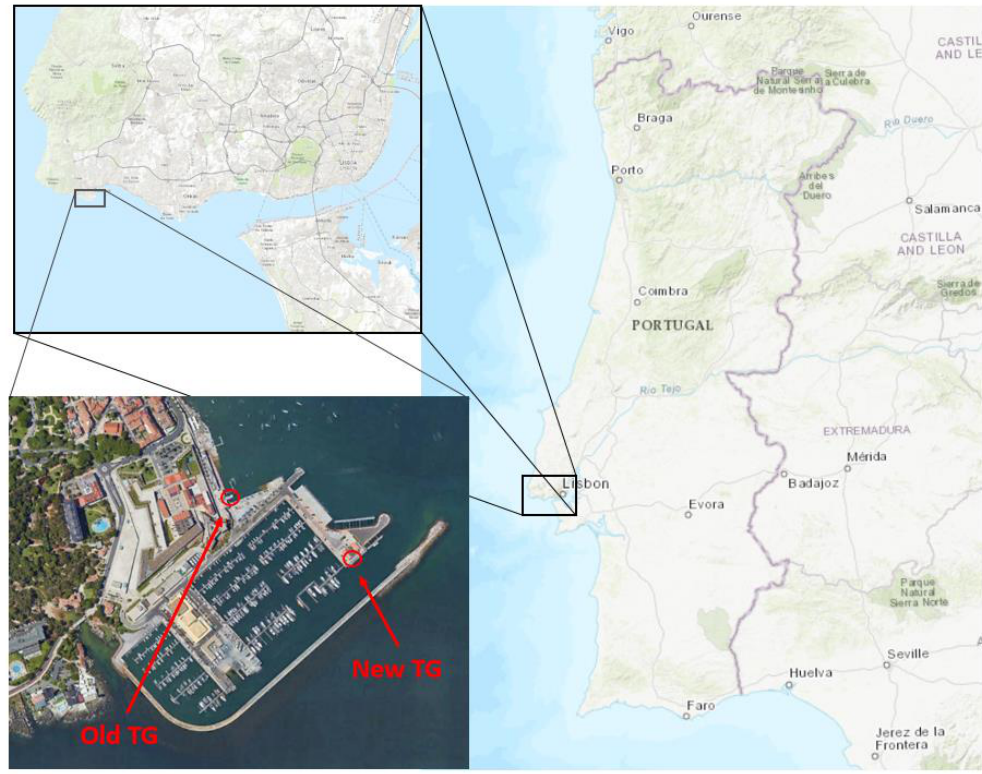
Figure 1. Location of Cascais tide gauge (TG). The old analog TG is operating since 1882, and the new acoustic TG with the digital record and with an internet connection is working since November 2003.